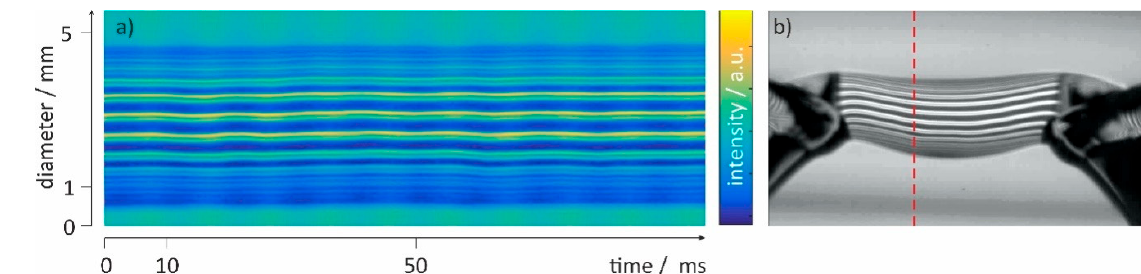
Figure 4. Time–space plot ( a ) from a water bridge ( b ) run at 1 7kV and 0.7 mA, bridge temperature ~40 °C, at the horizontal position indicated with a red, dashed line. In ( a ) the 100 Hz surface ripples caused by the waviness of the power supply can be seen by vertical deflection of the fringe patterns imaged through the bridge.